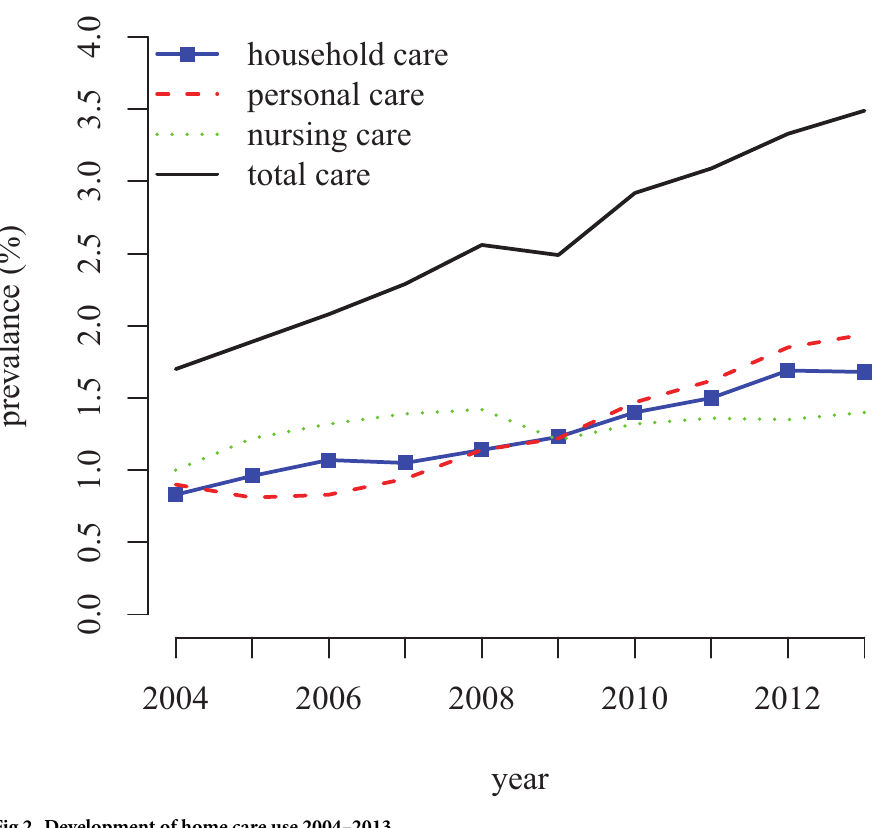
Fig 2. Development of home care use